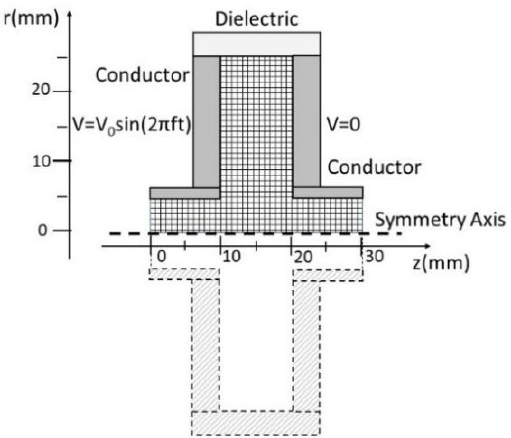
Figure 3. The simulated domain for the AC-PPP reactor in the 2-D model.